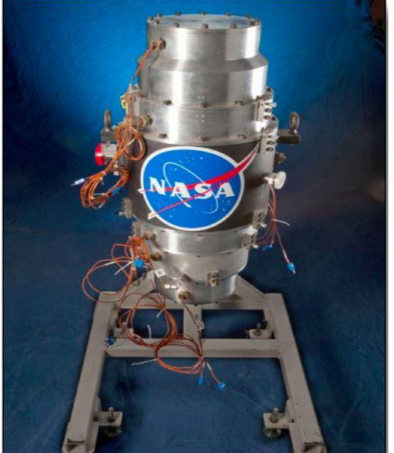
Figure 21. NASA flywheel and mounting bracket, adapted from